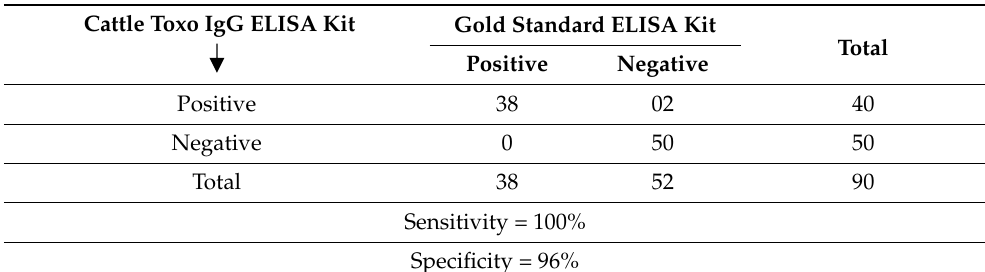
Table 6. Calculation of sensitivity and specificity of Cattle Toxo IgG ELISA kit against Gold Standard ELISA kit (Commercial ELISA kit) ( n = 90).